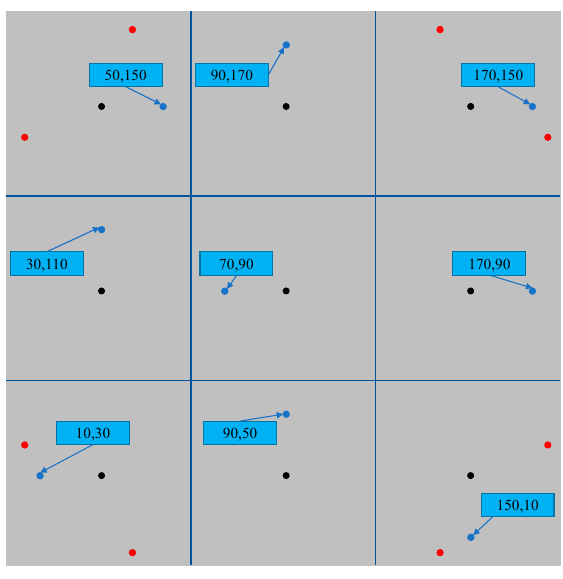
Figure 11. Prediction results when the excitation point of the test set is within 10 mm of the center.